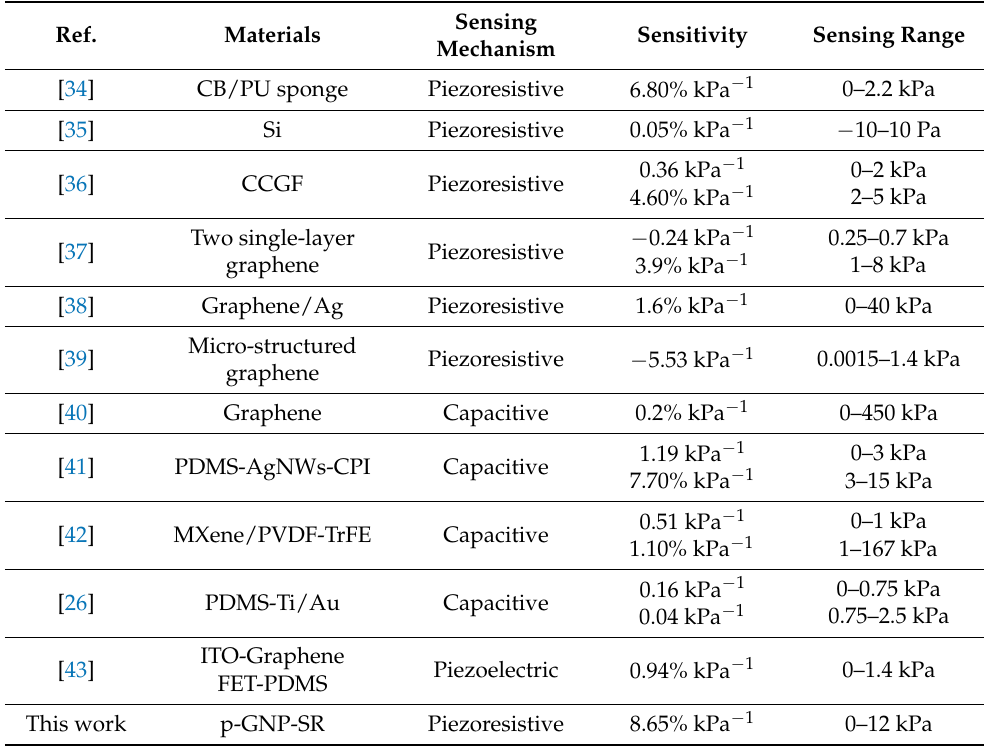
Table 1. The comparison of the sensing performance in this paper and some other related works.